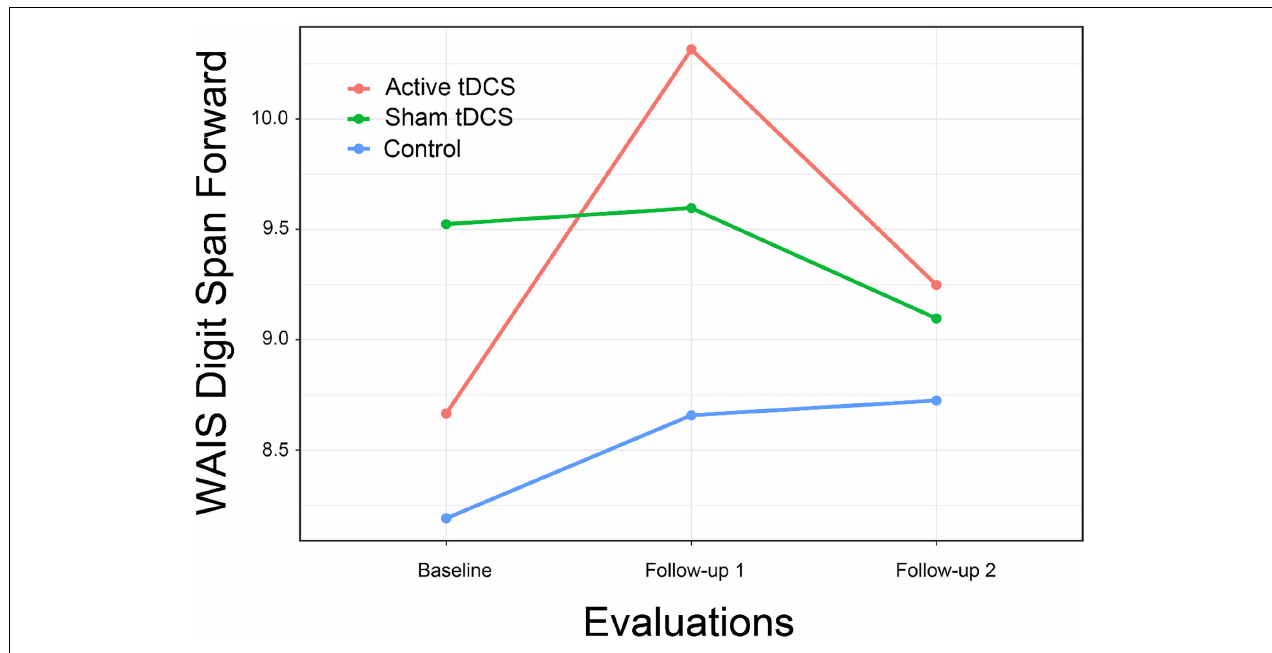
FIGURE 3 | WAIS-IV Digit Span Forward subtest score by Group and Time.